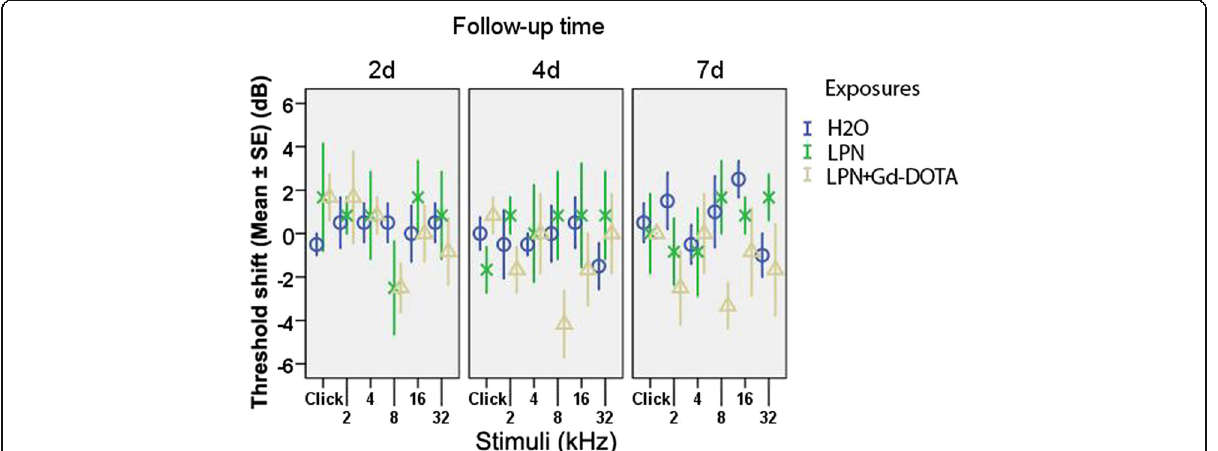
Fig. 3 Impact of transtympanic injection of liposome nanocarriers on hearing function in rats measured by the auditory brainstem response. Hearing loss was expressed as threshold shifts. There was insignificant difference among groups ( p > 0.05, one-way ANOVA). n = 6 in each group. H2O transtympanic injection of deionized water in negative control group, LPN empty liposome nanocarrier, LPN+ Gd-DOTA Gd-DOTA-containing LPN, 2d , 4d , and 7d 2, 4, and 7 days after injection